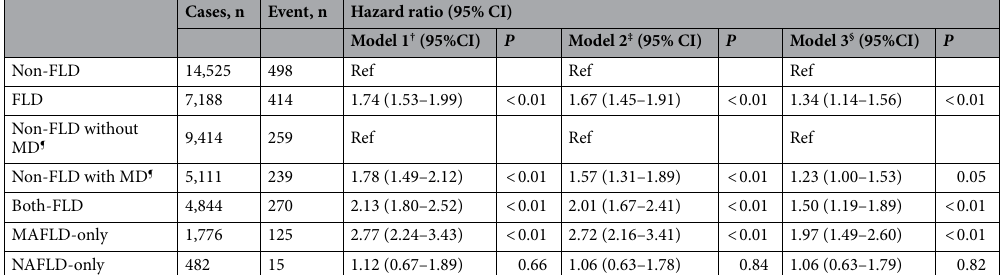
Table 2. Associations of MAFLD and NAFLD status with incident CKD. CI confidence interval, CKD chronic kidney disease, FLD fatty liver disease, MAFLD metabolic dysfunction–associated fatty liver disease, MD metabolic dysregulation, NAFLD nonalcoholic fatty liver disease. † Model 1 was crude. ‡ Model 2 was adjusted for age and sex. § Model 3 was adjusted for age, sex, estimated glomerular filtration rate, smoking, physical activity, prediabetes, diabetes, hypertension, cardiovascular disease, NAFLD fibrosis score, body mass index. ¶ Metabolic dysregulation; subjects with overweight/obese (body mass index ≥ 23 kg/m 2 ) or had diabetes (fasting plasma glucose [FPG] ≥ 126 mg/dl, hemoglobin A1c [HbA1c] ≥ 6.5%, or specific drug treatment), or at least two of the following metabolic risk abnormalities: (i) waist circumference ≥ 90 cm in men and ≥ 80 cm in women; (ii) blood pressure ≥ 130/85 mmHg or specific drug treatment; (iii) triglycerides ≥ 150 mg/dl; (iv) HDL-C < 40 mg/dl for men and < 50 mg/dl for women; (v) prediabetes (FPG 100–125 mg/dl or HbA1c 5.7–6.4%); (vi) homeostasis model assessment of insulin resistance ≥ 2.5; and (vii) high-sensitivity C-reactive protein > 2